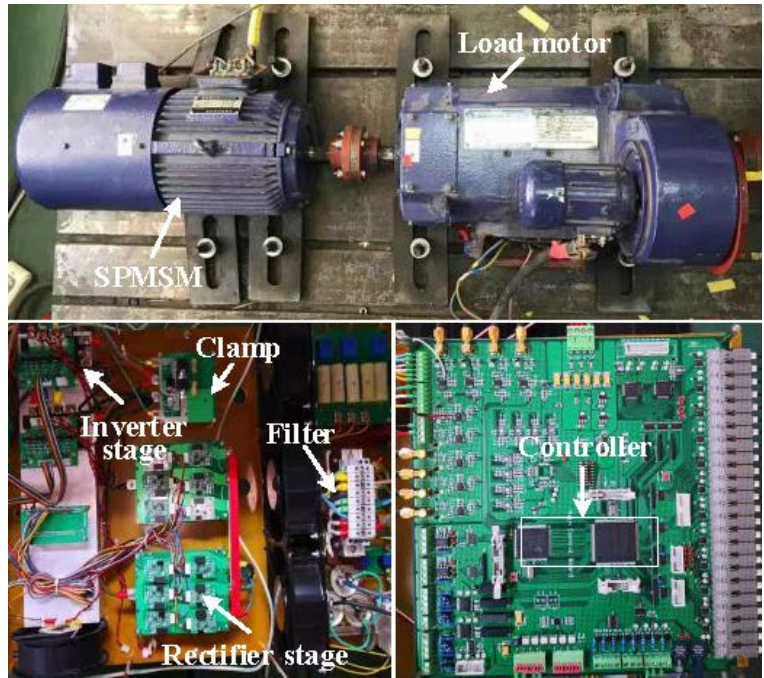
Figure 14. Experimental prototype of IMC-SPMSM.